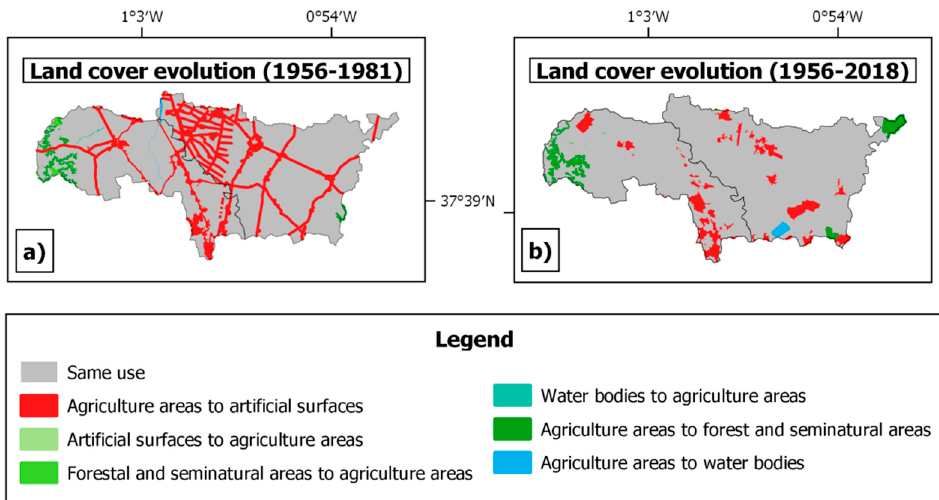
Figure 7. Land cover changes in the Rebollos and Miranda watersheds. ( a ) Changes determined between 1956 and 1981; ( b ) changes detected between 1956 and 2018.